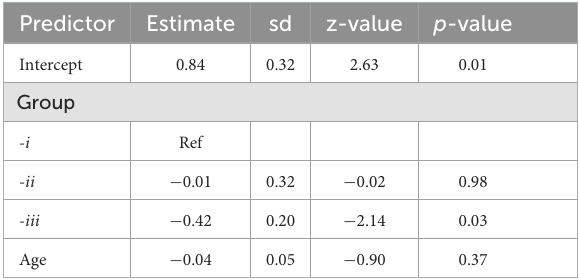
TABLE 4 Mixed effects Poisson regression model results including predictor estimates, standard deviation (sd), statistic (z-value), and p